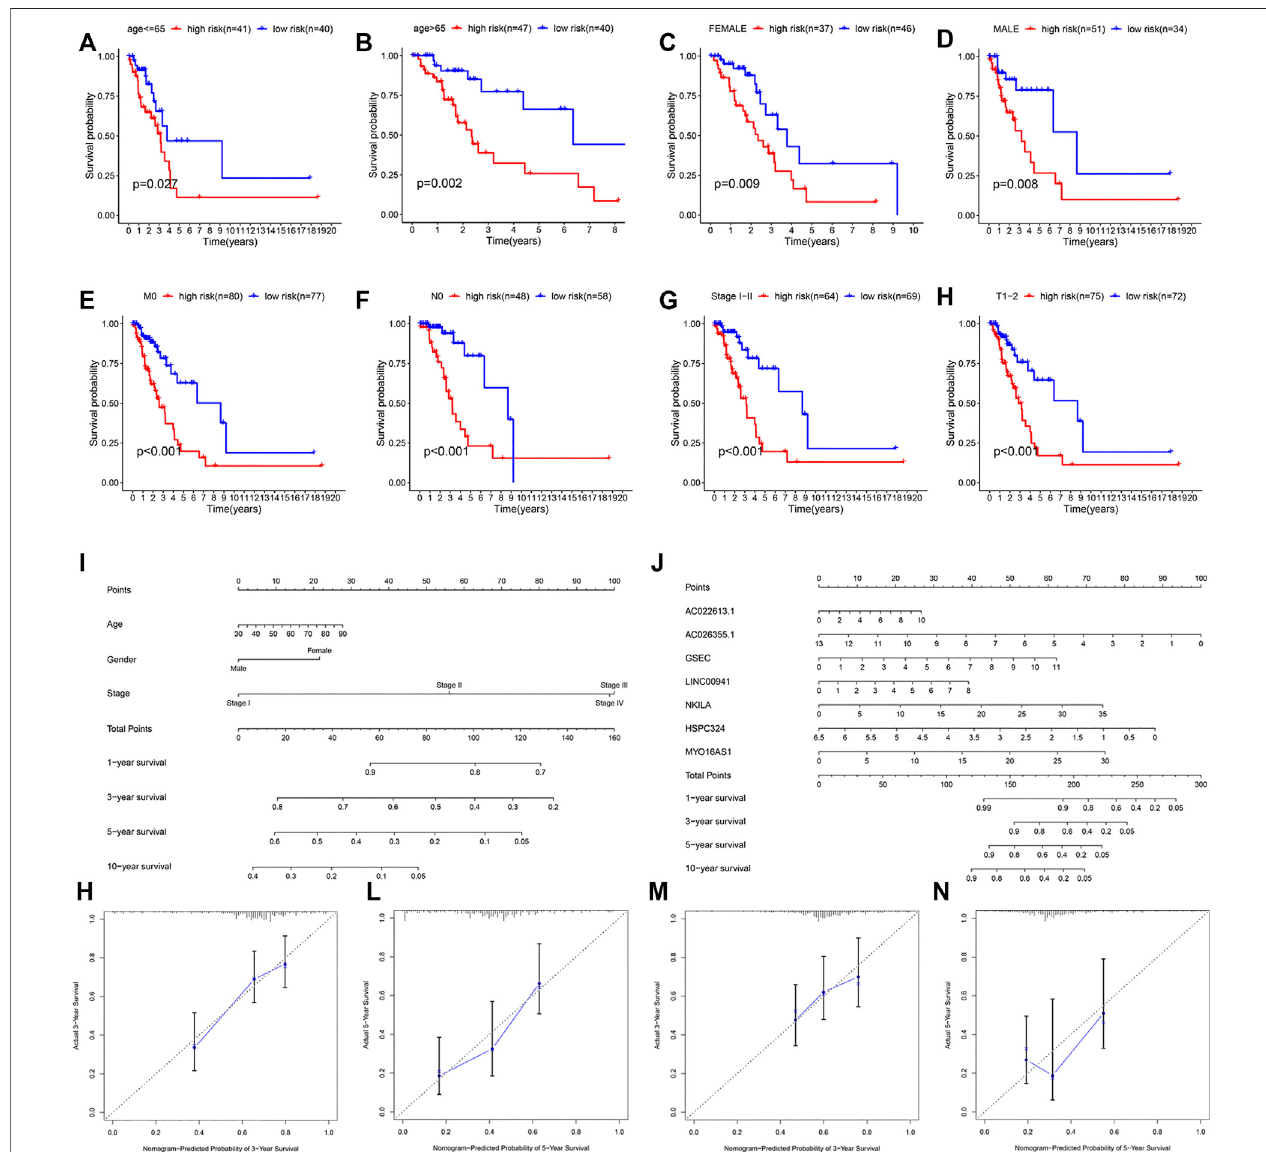
FIGURE 6 | Strati fi cation analysis of various clinico-pathological factors, nomograms used to predict the OS prognosis, and calibration plots used to predict prognosis in these patients with LUAD. KM curves of OS in the subgroups of (A,B) both the age groups, (C,D) both gender groups, (E) M0 group, (F) T0 group, (G) clinicalstageI – IIgroup,and (H) T1 – 2group. (I,J) Nomogramstopredictthe1-,3-,5-,and10-yearOS.Calibrationplotsfor3-yearsurvivaland5-yearsurvival (K,L) inthe training and (M,N) validation